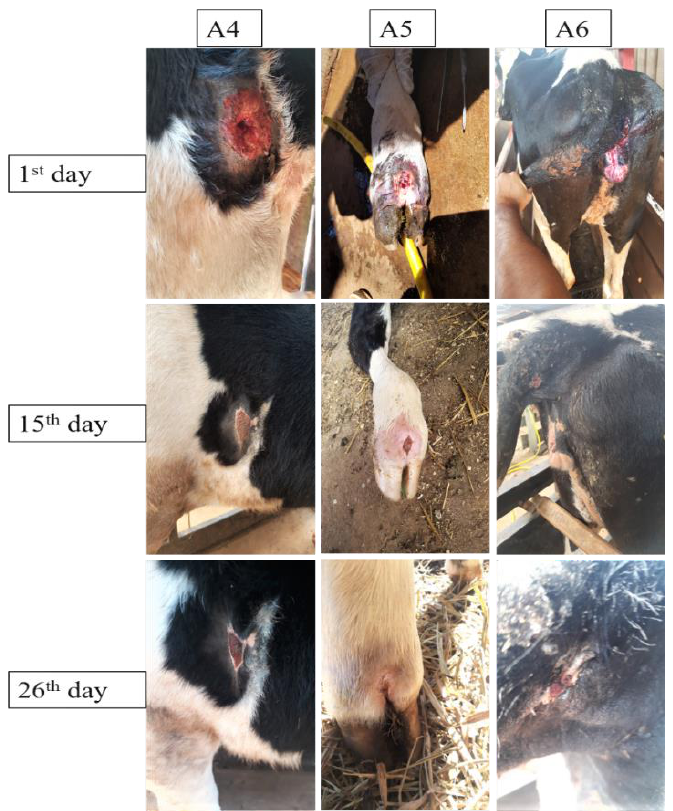
Figure 7. Monitoring photographs of animals treated (A4 – A6) with ECO 20 . The pictures show lesions in the back lumbar region (accidental injury — A4), the rear (accidental injury — A5), and in the tail insertion (accidental injury — A6).